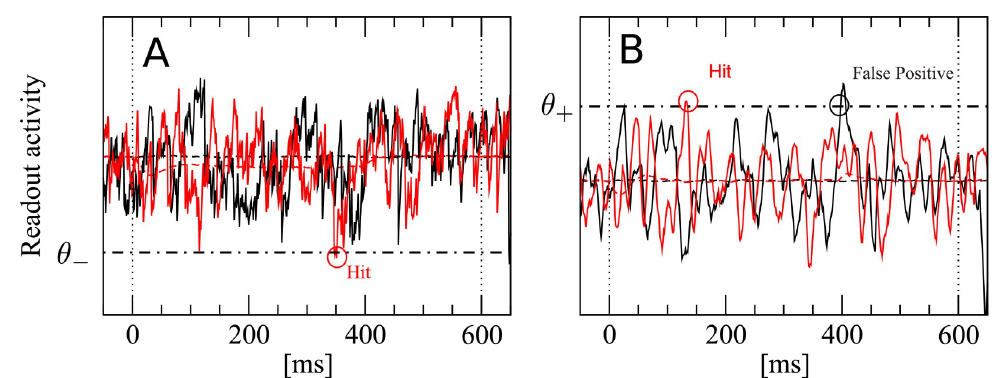
Fig 3. A detection event is defined by a lower threshold crossing for the integrator readout (IR) and by an upper threshold crossing for the differentiator readout (DR) and the differentator network readout (DNR). We show here an example for the IR ( A ) and the DR ( B ). A : The black trace represents one realization of the IR readout activity during one catch trial (i.e. in the absence of stimulus). The red trace represents one realization of the readout activity in the presence of a stimulus. B : Same for the DR. The readout activity of the IR and DR are defined in Eqs (1) and (4), respectively. The IR reacts whenever the readout activity falls at least once below the detection boundary θ − (dashed-dotted line) within the detection time window (delimited by vertical dotted lines). The DR and the DNR react whenever the readout activity exceeds at least once the detection boundary θ + (dashed-dotted line) within the detection time window (delimited by vertical dotted